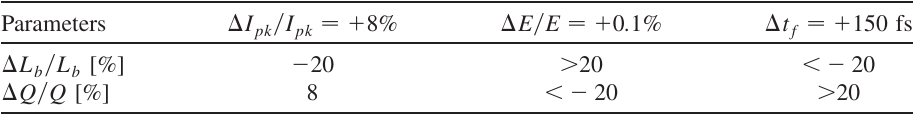
TABLE IV. Individual sensitivities. Each parameter variation causes a (cid:1) I pk =I pk ¼ þ